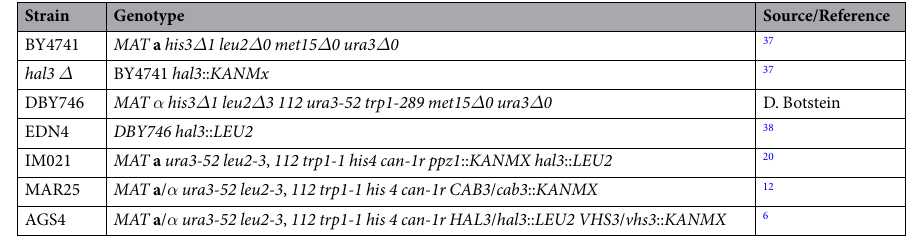
Table 1. Yeast strains used in this